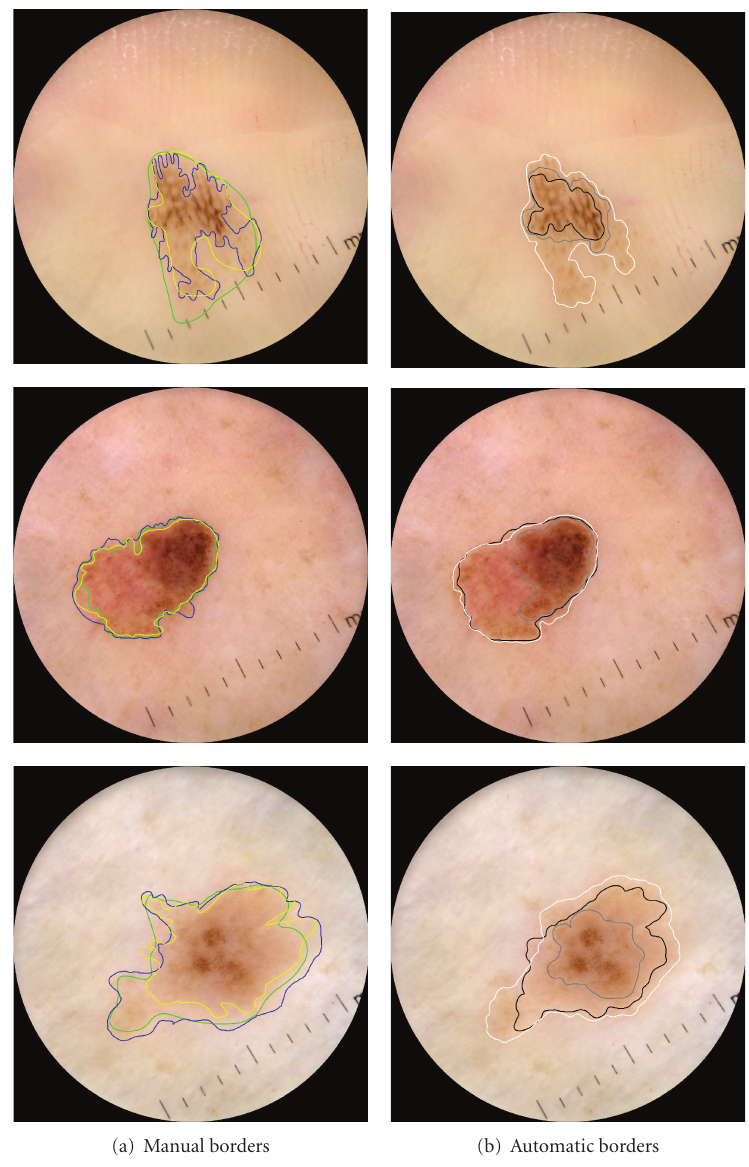
Figure 8: Example of lesions in the test set and the border provided by (a) the three dermatologists and (b) the automatic borders by AT (black border), SRM (gray border), and the proposed ICS algorithm (white border). None of the methods performed better in all